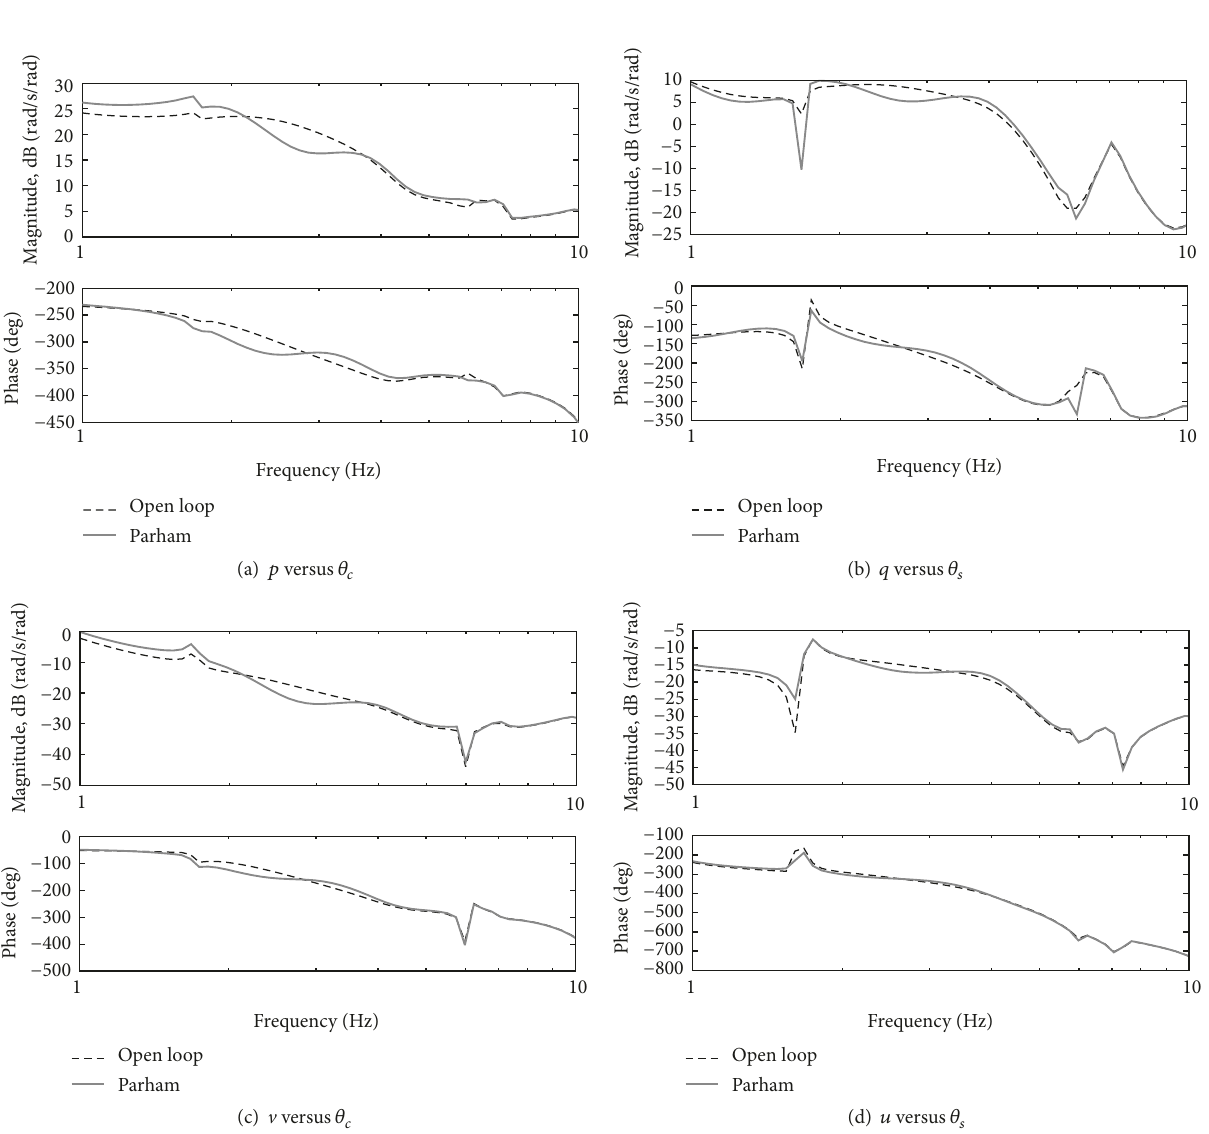
Figure 12: Helicopter transfer functions for in-the-loop and out-of-the loop lateral control